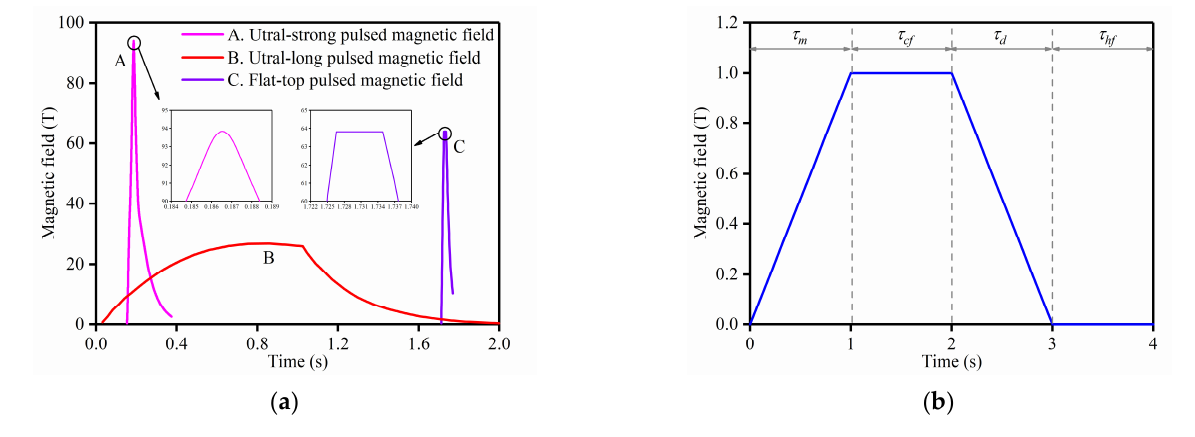
Figure 1. Typical pulsed and permanent magnetic field waveforms. ( a ) Pulsed magnetic field; ( b ) permanent magnetic field.